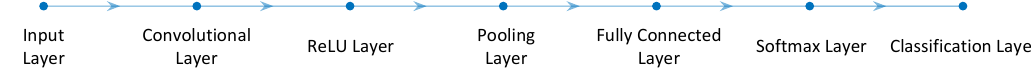
Figure 5. Layer architecture